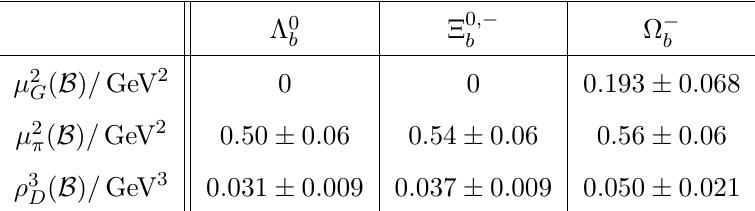
Table 5 . Non-perturbative parameters for the non-spectator contributions used in our analysis. Values for µ 2 ( B ) follow from the relations derived in eqs. (2.64) and (2.68), with µ 2 π the fit value in [130] and µ 2 ( B s ) obtained using the SU(3) F -breaking estimate from [133]. Values π for ρ 3 ( B ) follow from employing the equation of motion (2.73). The errors quoted here are obtained D by combining in quadrature the parametric uncertainty and the uncertainty due to missing power